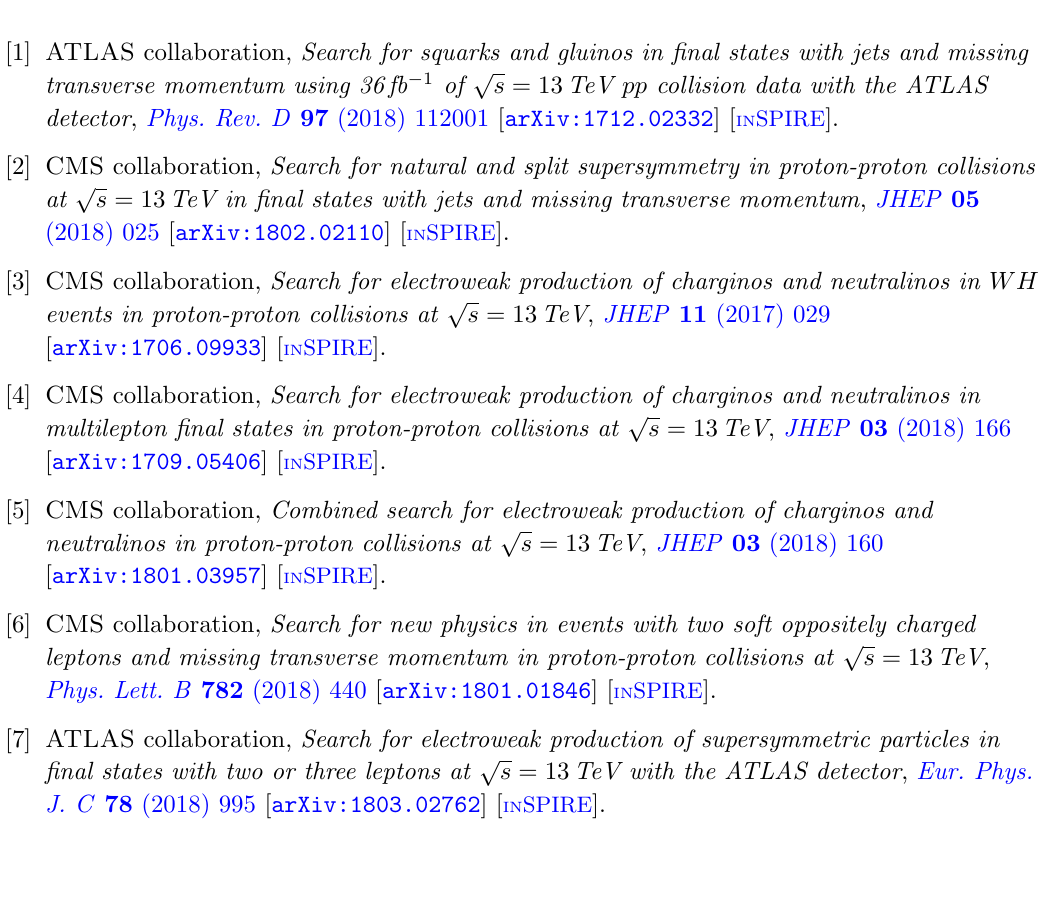
(cid:31) 0 (cid:31) 0 Z + 2 (cid:31) 0 electroweakino search 1 ! 1 h !